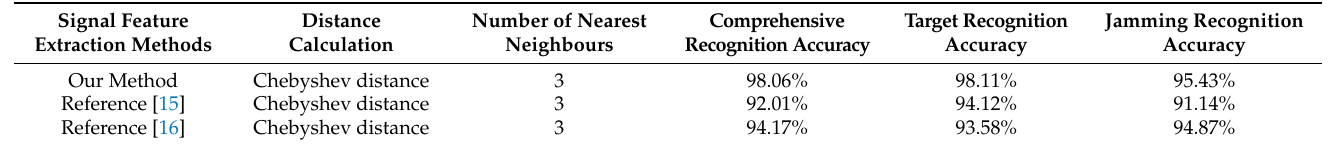
Table 3. Comparison of the performance of the proposed signal feature extraction method with the reference.